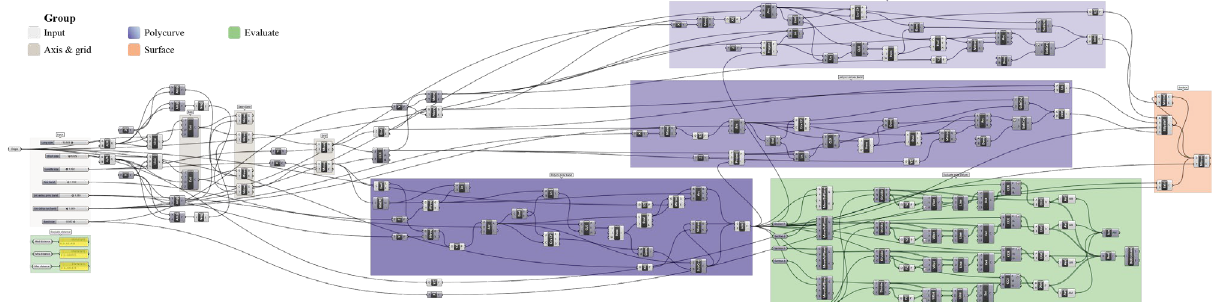
Figure 12 . Canvas view of independent arches realized with Grasshopper (Processing: F.